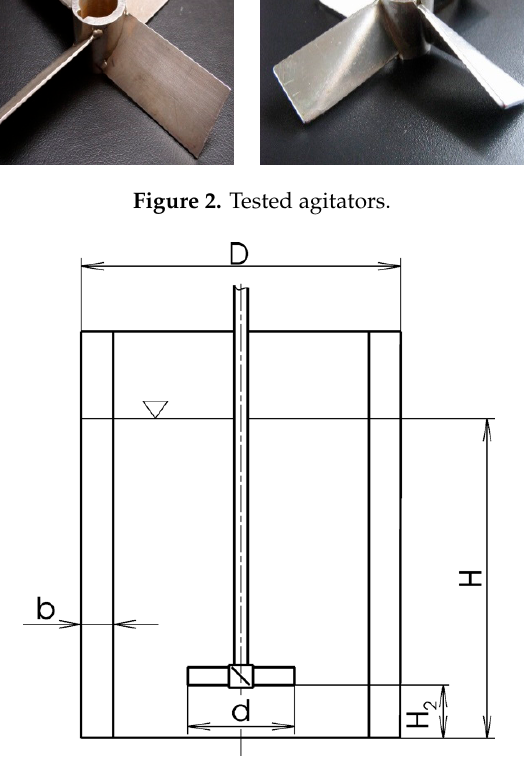
Figure 3. Geometrical arrangement of the experimental mixing equipment (geometrical parameters of vessel: D = 290, 600, and 800 mm; H/D = 1; b/D = 0.1).